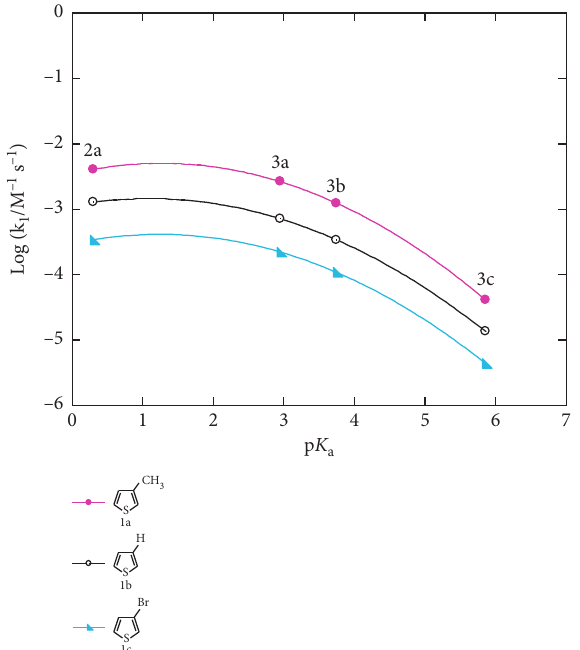
Figure 7: Bronsted nonlinear correlations: influence of electro- philic acidity 2a and 3a-c on bimolecular rate constants, k 1 , related to the coupling reaction of the thiophene 1a-c with the electrophiles 2a and 3a-c in acetonitrile at 20 ° C.